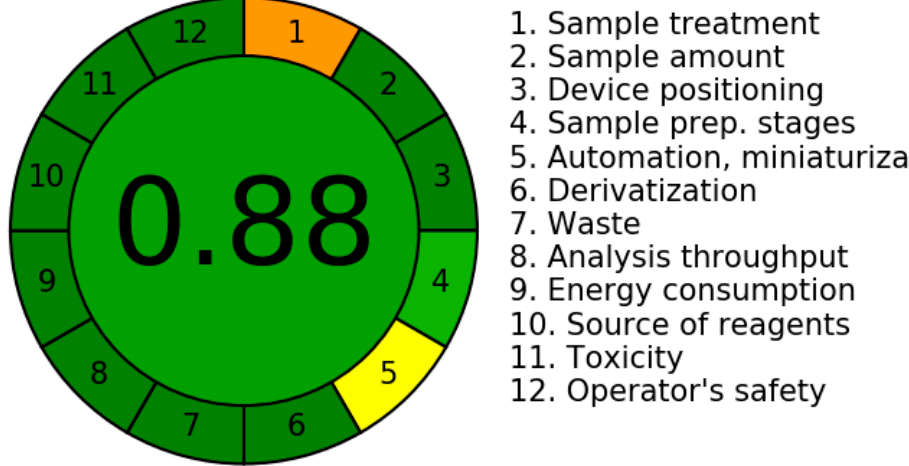
Figure 5. “ Analytical GREEnness (AGREE)” index for the developed method. Figure 5. “Analytical GREEnness (AGREE)” index for the developed method.